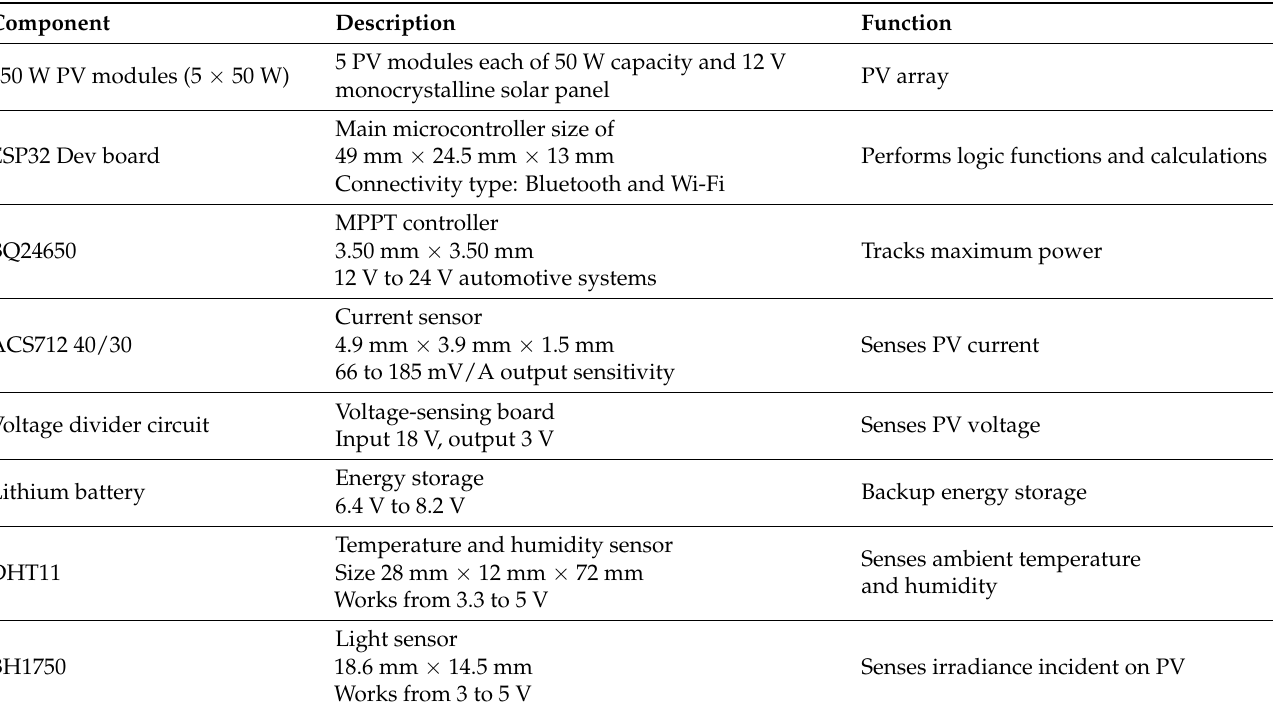
Table 1. List of hardware components.